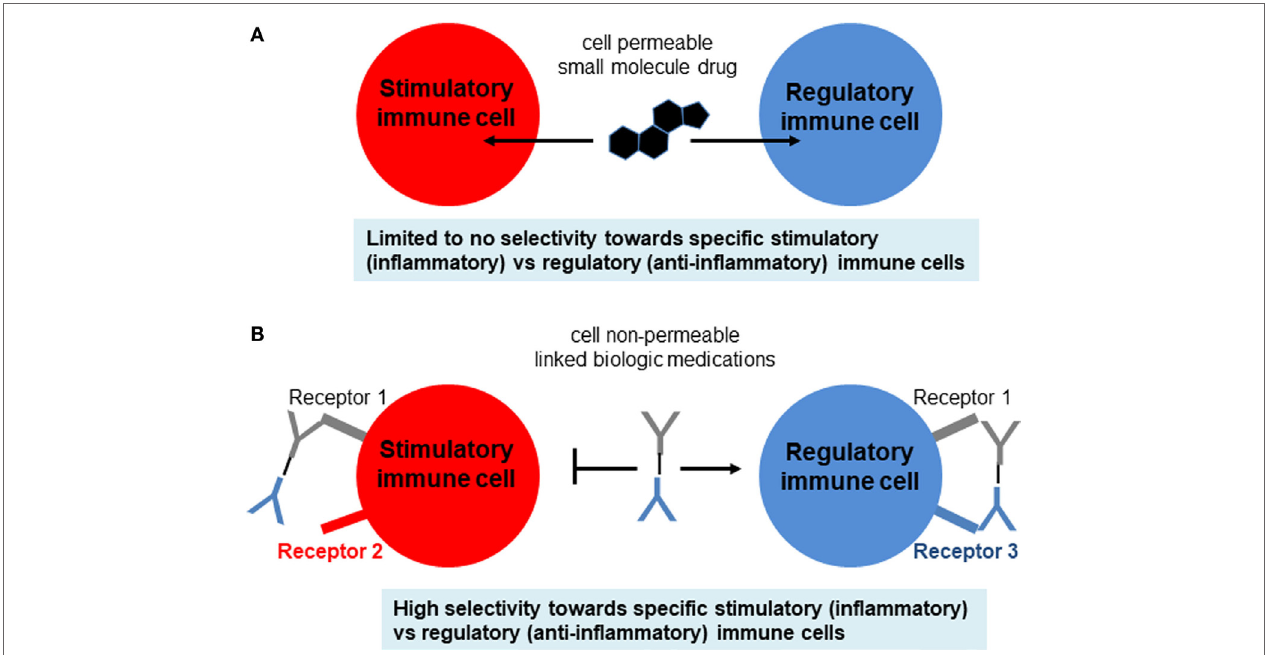
FigURe 2 | Comparison of small molecule drugs and complex biologics. (A) Small molecule drugs for immunosuppressive therapy include the well-known corticosteroids, nucleotide synthesis inhibitors, NFAT pathway inhibitors, and mTOR pathway inhibitors. Although some immune cells may express more intracellular targets than other types of immune cells, typically the selectivity of small molecule drugs for target vs off-target cells is not high enough and, therefore, leads to side effects. (B) Biologics include antibodies (which can be blocking, stimulatory, or inhibitory), cytokines, and cytokine receptors or decoys that either amplify or attenuate cytokine signaling. These biologics are usually administered as pure agents, or are further integrated on carrier platforms (such as nanoparticles, liposomes, polymers). If biologics are linked to each other or to carriers/platforms, then additional considerations apply to optimization of linkers (free, fused, tagged,